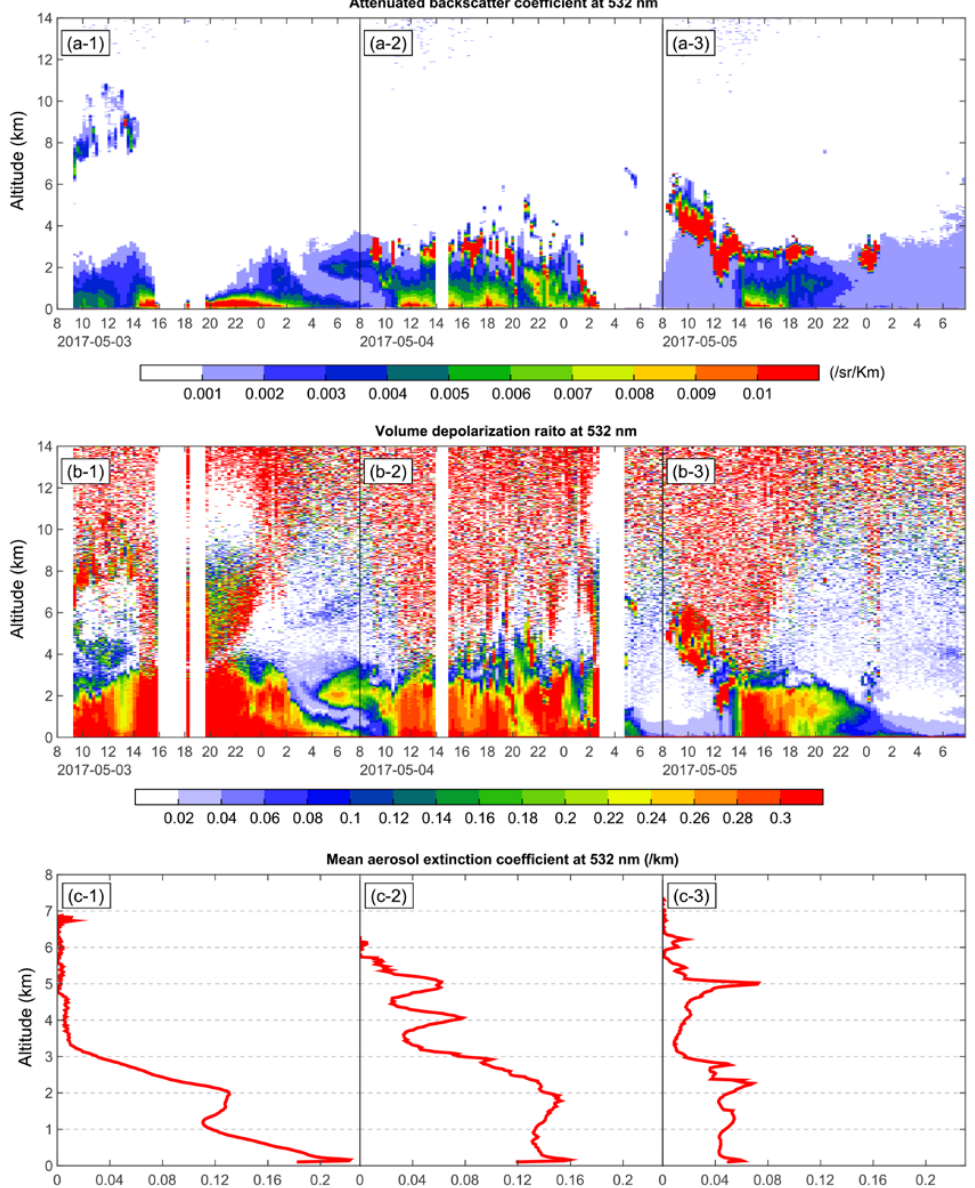
Figure 7. Variation of aerosol parameters measured by Lidar in Inner Mongolia on 3–5 May 2017. (( a-1 ) to ( a-3 ), ( b-1 ) to ( b-3 ) and ( c-1 ) to ( c-3 ) respectively describe the attenuated backscatter coe ffi cient, volume depolarization ratio and mean aerosol extinction coe ffi cient at 532 nm on 3–5 May 2017)